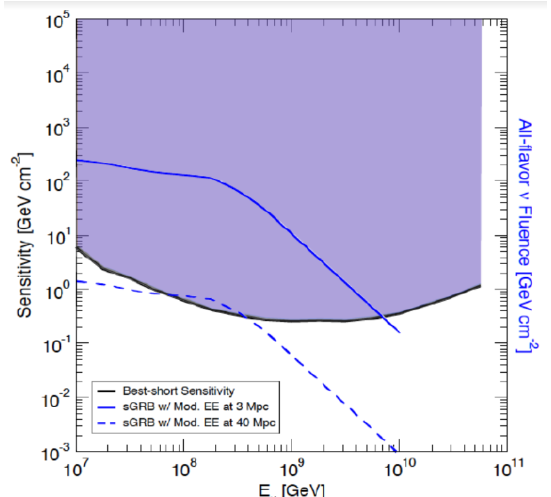
Figure 10: All-flavor “best-case” short-duration transient sensitivity band for EUSO-SPB2. For comparison, solid and dashed blue lines present the all-flavor neutrino flu- ences from the short gamma-ray burst with extended emis- sion model of [18], placing the source at various distances.